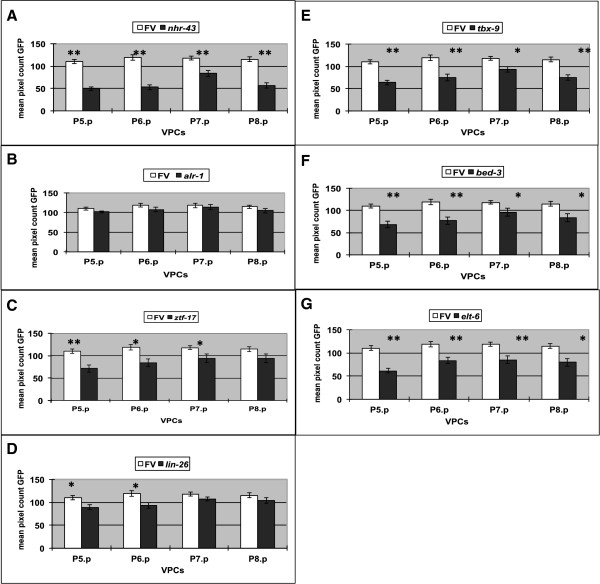
Seven transcription factors affect lin-39::GFP expression in the VPCs at early L3 stage.smg-1; deIs4(lin-39::GFP) animals were treated for RNAi of individual transcription factors (panels A–G, dark bar), or control RNAi (panels A–G, light bar) as in Figure 2. Early L3 stage animals were photographed at the same exposure, and pixel counts in each VPC were determined using ImageJ (>20 animals for each strain). Bars show mean GFP pixel count in each cell with standard deviation. ‘*’ indicates P-value < 0.05. ‘**’ indicates P-value < 0.001, compared to control animals.